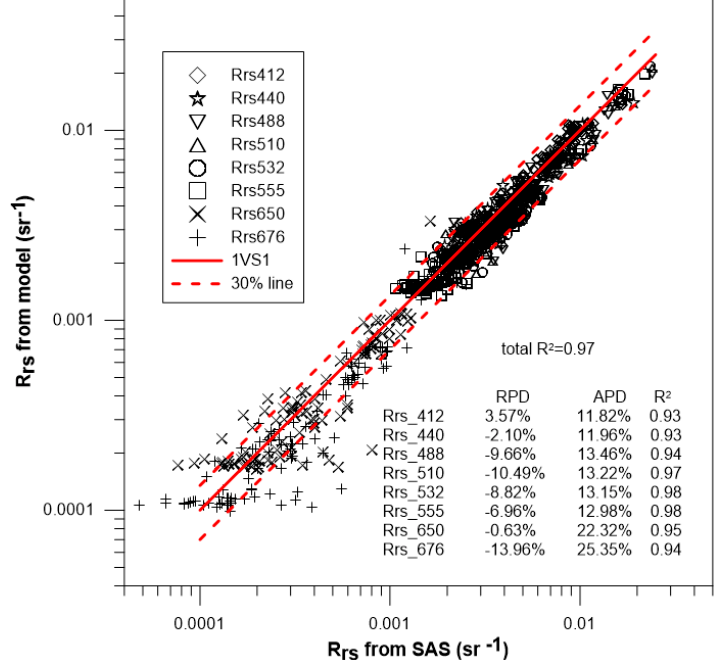
Figure 3. Difference between the in-situ 𝑅 (cid:3045)(cid:3046) and the 𝑅 (cid:3045)(cid:3046) estimated from the GSM model using the Figure 3. Di ff erence between the in-situ R rs and the R rs estimated from the GSM model using the in-situ IOPs. in-situ